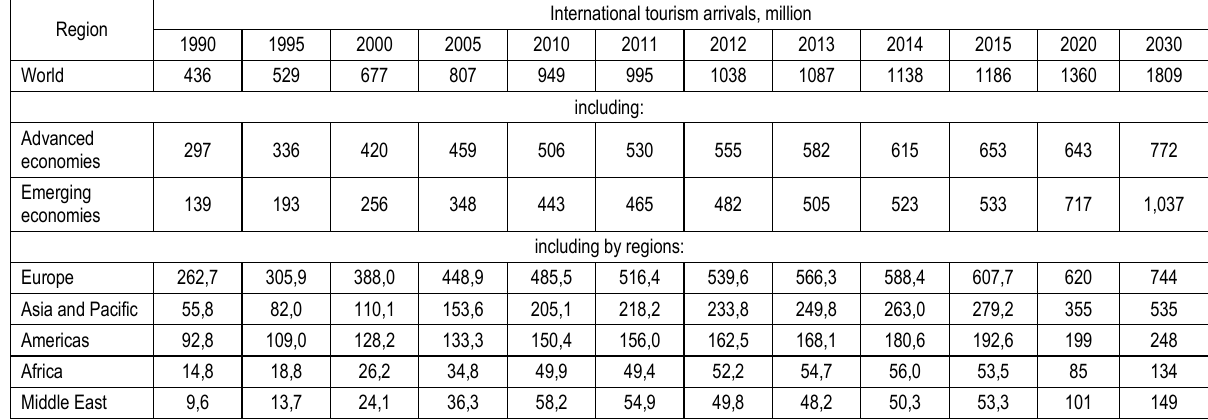
Table 1. Dynamics and forecast of international tourism development*